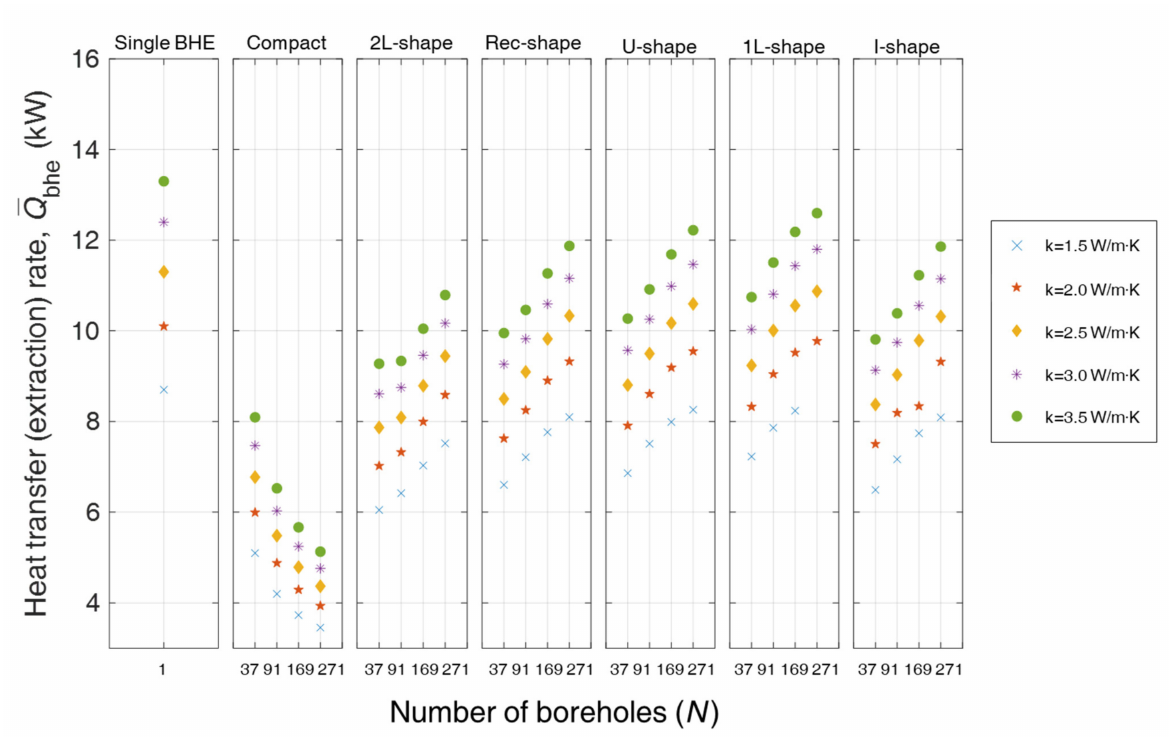
Figure 7. Variation in the heat transfer rate ( Q bhe ) for test configurations of bore field (heating-dominant